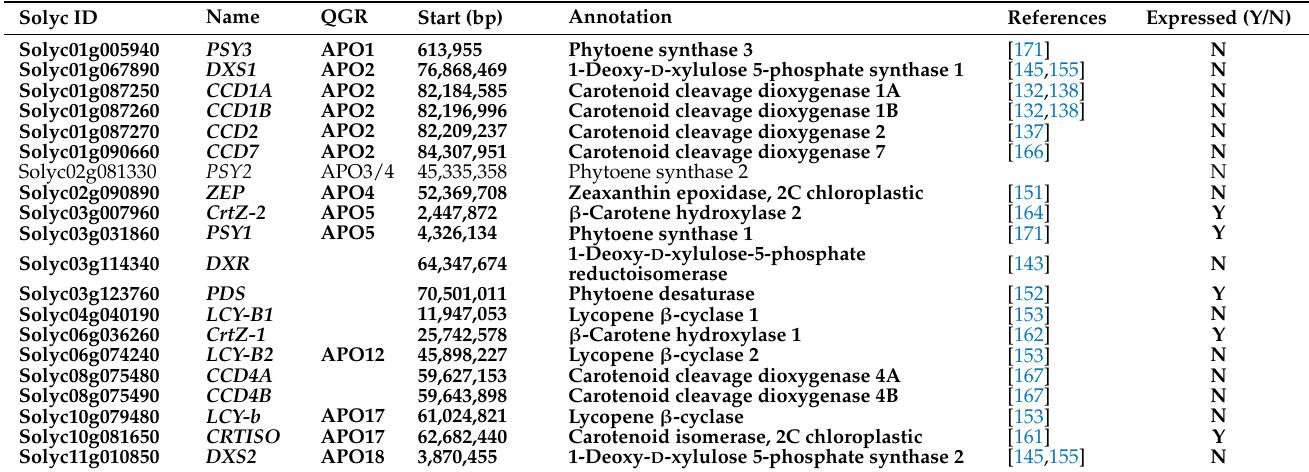
Table 5. List of the genes identified as potentially responsible for the carotenoid VOCs QTL reported in literature. Genes that have been functionally characterized are highlighted in bold in the table. The last column reports whether the gene has been reported to be expressed in fruit (Y/N—[103]); for a complete overview of the gene expression see Table